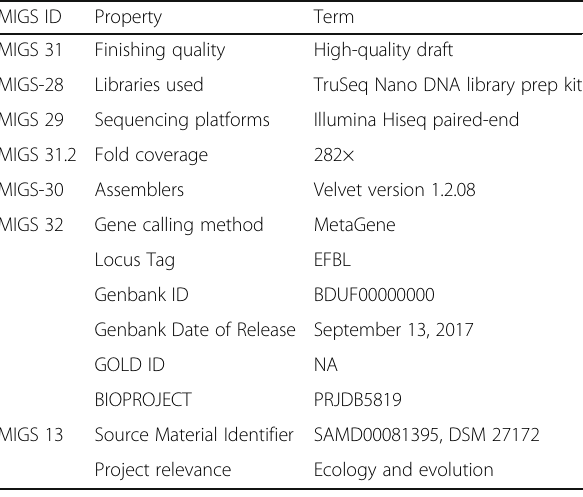
Table 2 Project